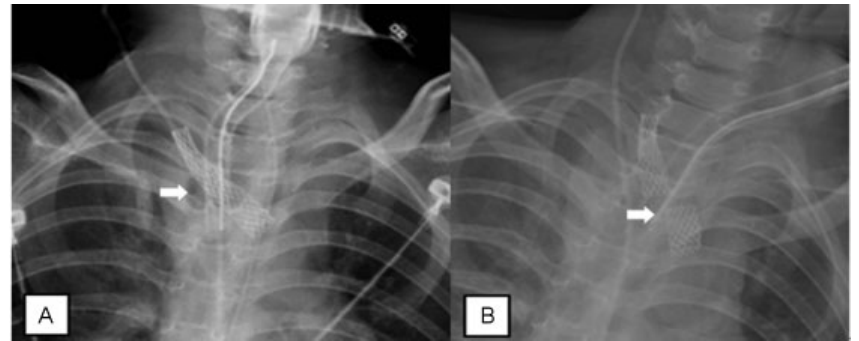
Fig. 1 (A) Initial chest X-ray after endovascular stent graft repair (arrow) of the innominate artery. (B) Chest X-ray shows the migrated stent fragments (arrow) that developed due to stent graft fracture